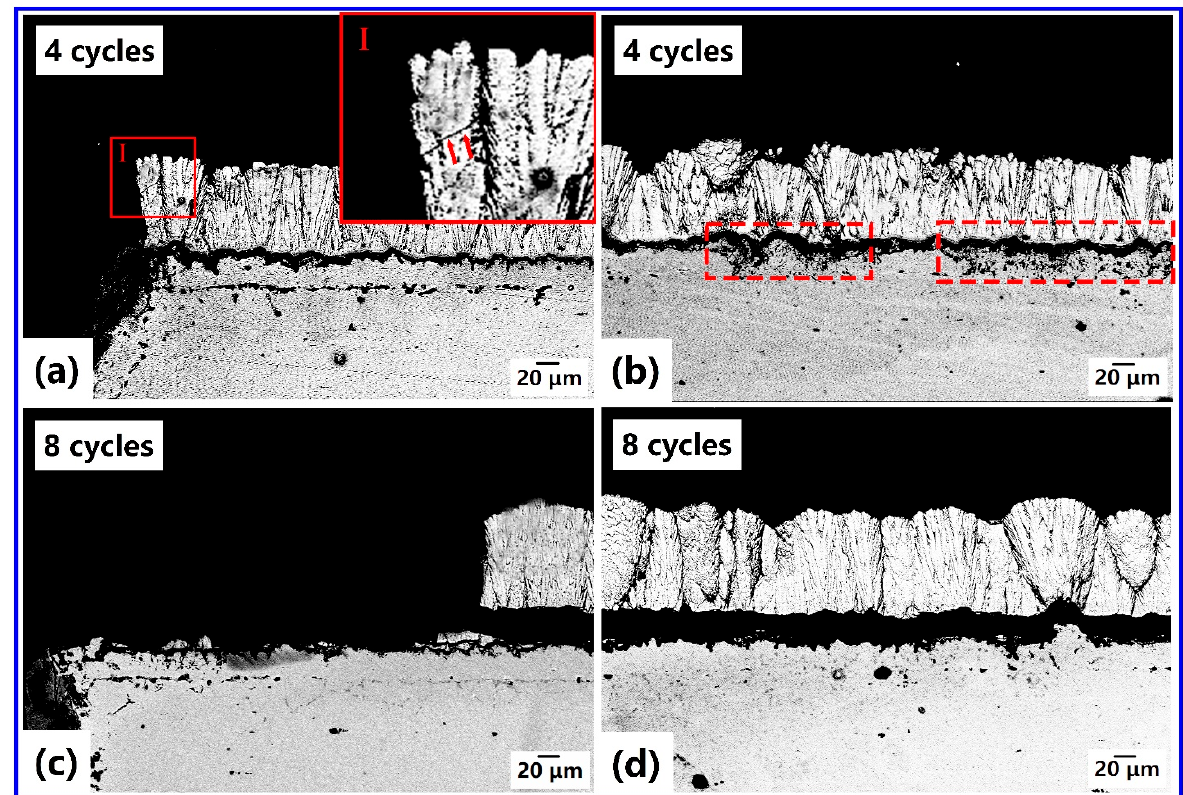
Figure 9. Cross-sectional morphologies of YSZ with NaCl: ( a ) edge of coating after four cycles; ( b ) center of coating after four cycles; ( c ) edge of coating after eight cycles; ( d ) center of coating after eight cycles. The red square area clearly shows the degradation of the bond coating.